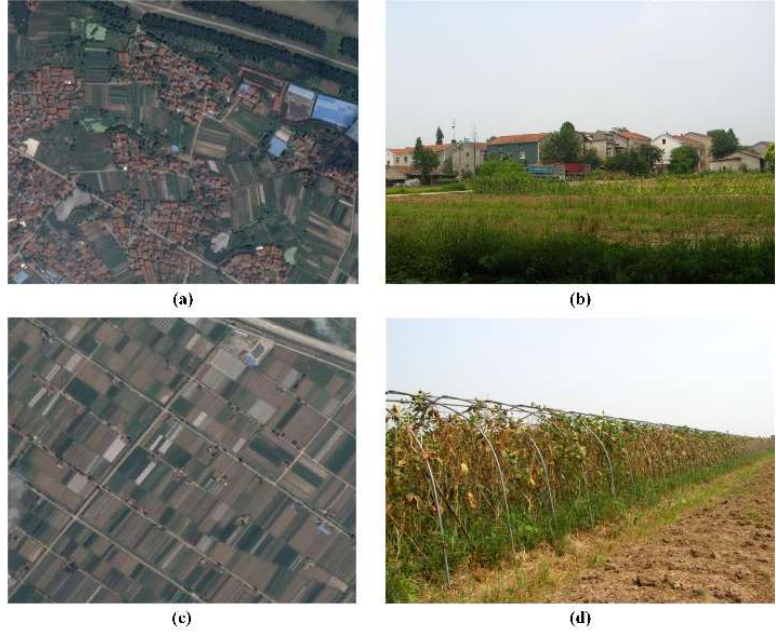
Figure 9. The ROIs in Figure 8 and field investigation images. ( a ) Corresponding Google Earth optical image of ROI_1; ( b ) the field investigation images in ROI_1 (latitude: 30° 39’ 48‘’, longitude: 114° 29’ 13‘’); ( c ) corresponding Google Earth optical image of ROI_2; and ( d ) the field investigation images in ROI_2 (latitude: 30° 39’ 06‘’, longitude: 114° 30' 54‘’).